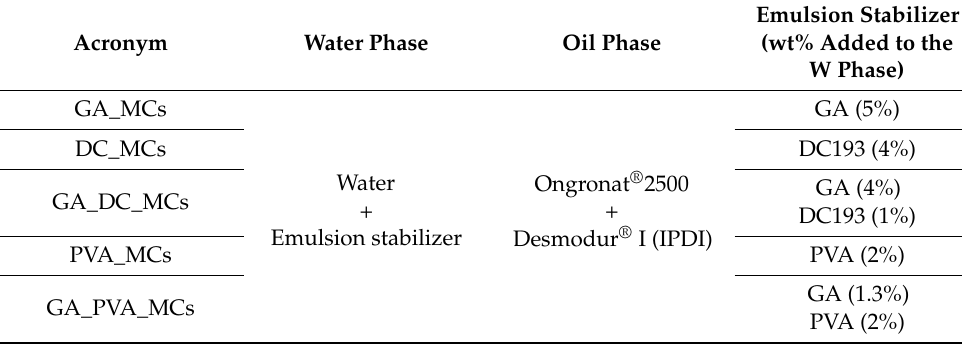
Table 1. Microcapsules’ acronyms and emulsion